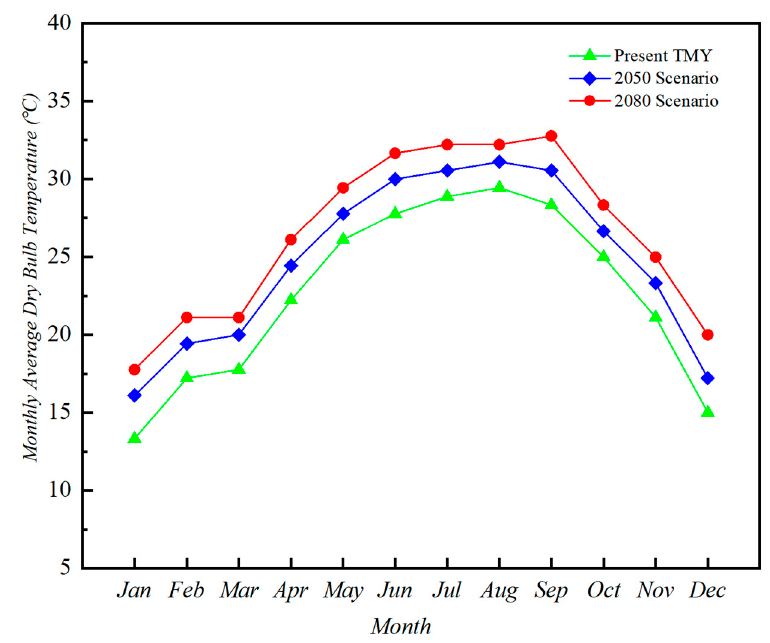
Figure 9. Monthly average dry bulb temperatures of present TMY and predicted future scenarios (2050 and 2080).